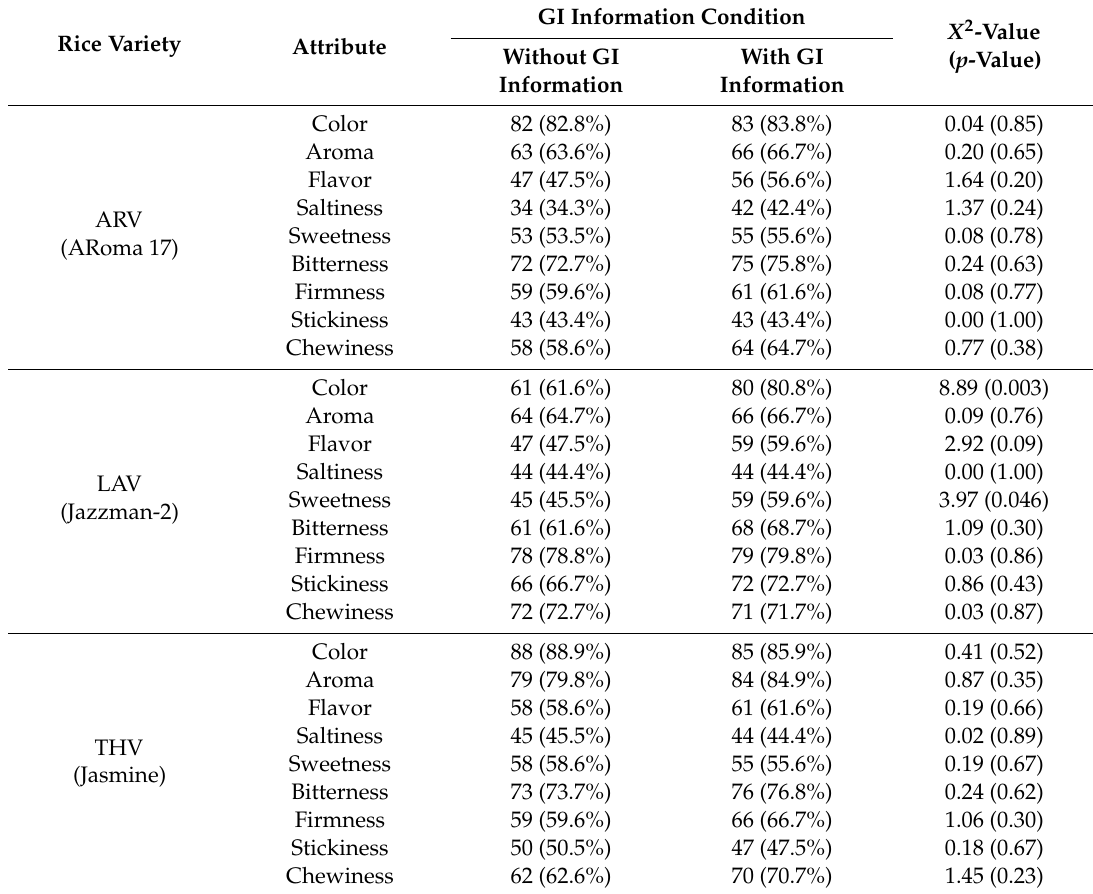
Table 2. Comparisons between the two geographical indication (GI) information conditions with respect to percentage of Just-About-Right (JAR) for each attribute in each rice